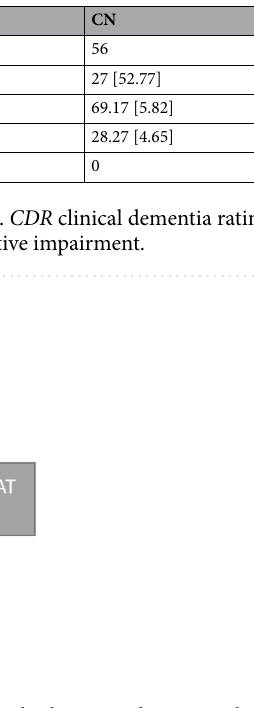
Figure 3. The procedure of the proposed method. Five evolutionary algorithms (EA) were used: genetic algorithm (GA), nondominated sorting genetic algorithm II (NSGA-II), ant colony optimisation (ACO), simulated annealing (SA) and particle swarm optimisation